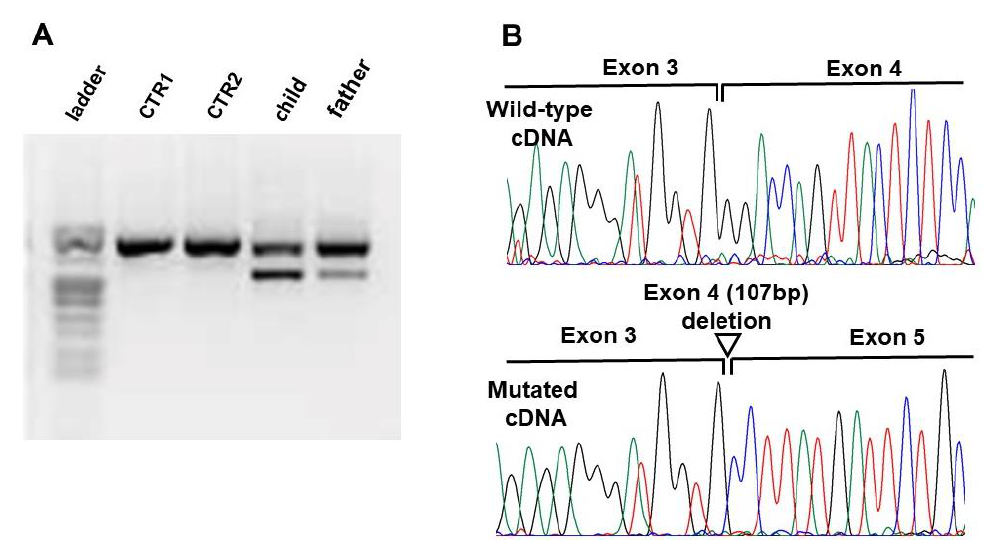
Figure 3. Transcript analysis of the WAC splicing mutation identified in Family 3. ( A ) Agarose gel electrophoresis of the Reverse Transcriptase PCR products in the control samples (CTRL1, CTRL2) patient, and his father. ( B ) Electropherograms of the wild-type (upper) and aberrant (bottom) transcript sequence at slicing position showing the skipping of exon 4.